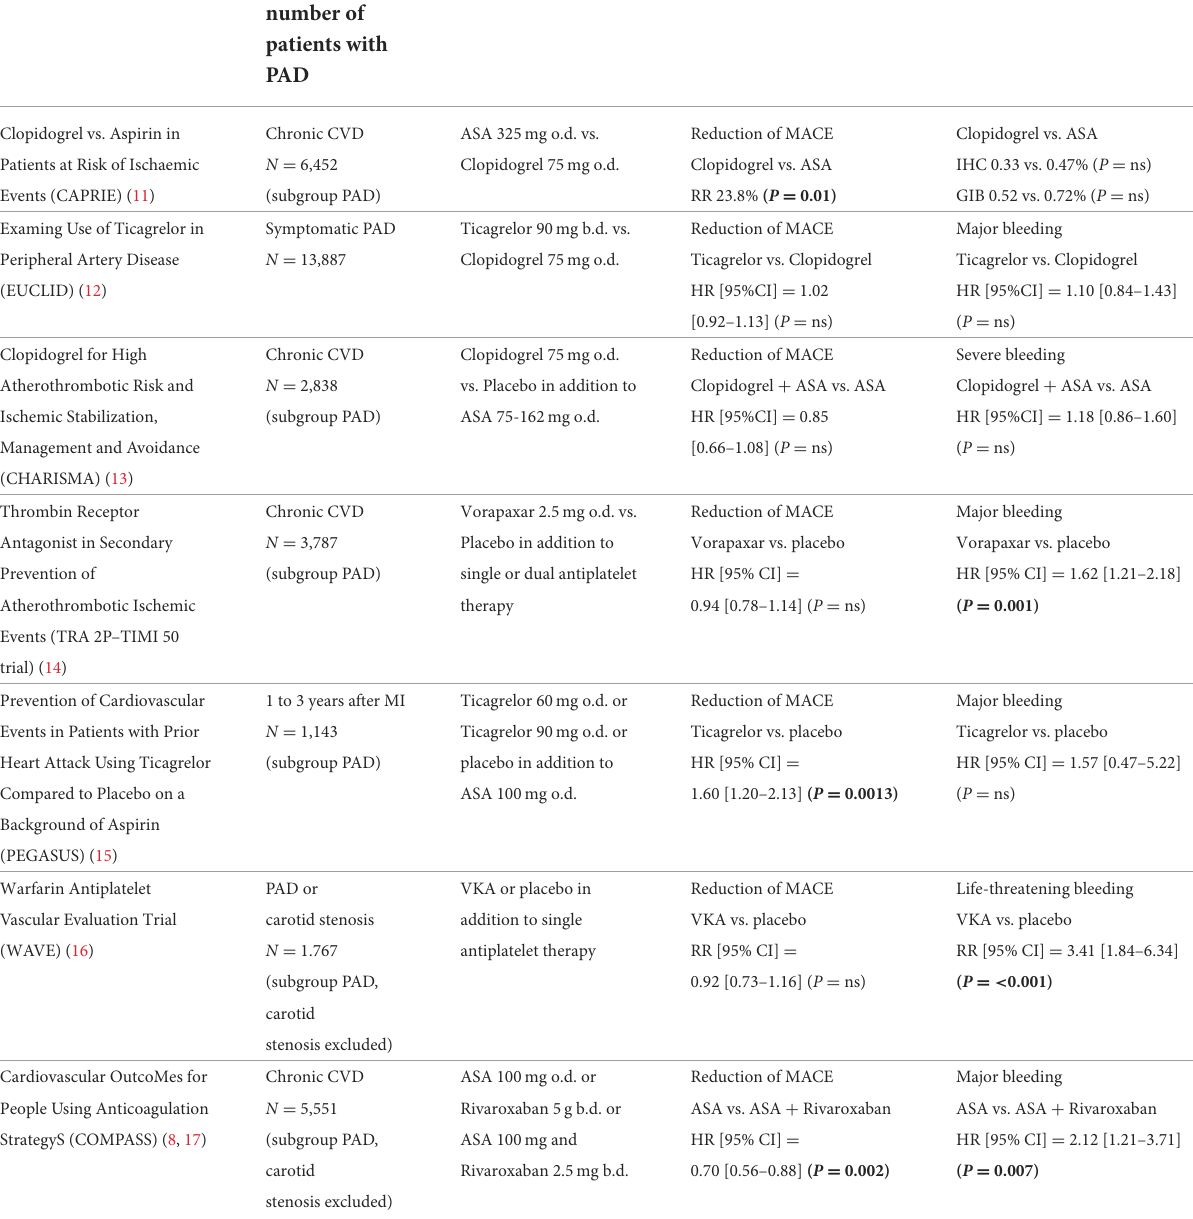
TABLE 1A Studies on antithrombotic therapy in patients with stable